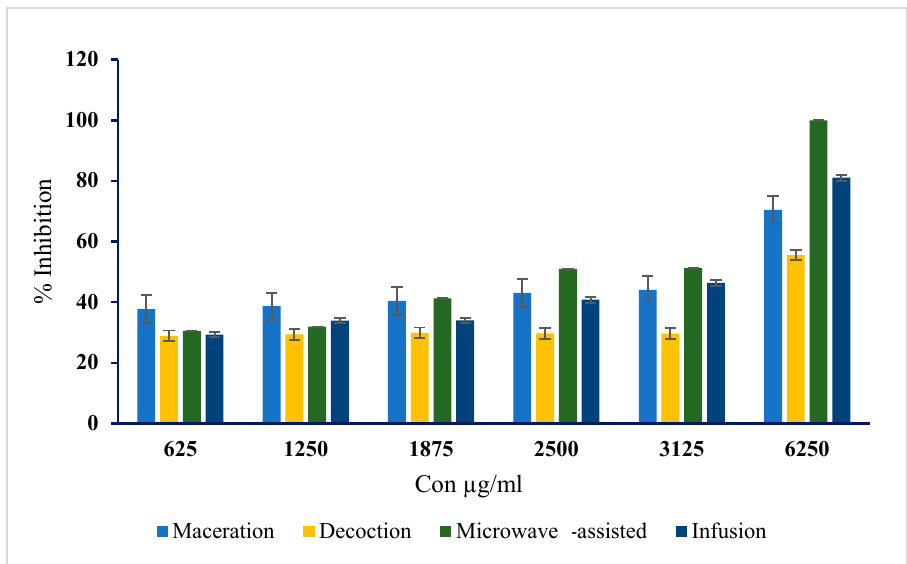
The in vitro α -glucosidase inhibition potential of the T. claveryi extracts was evalu- ated. The percentage of the enzyme inhibition as a function of the concentration and the type was detected. The IC 50 was calculated from the graph (Figure 4). Concentration-dependent inhibitory activity was observed for all tested extracts, as well as the standard at various concentrations.